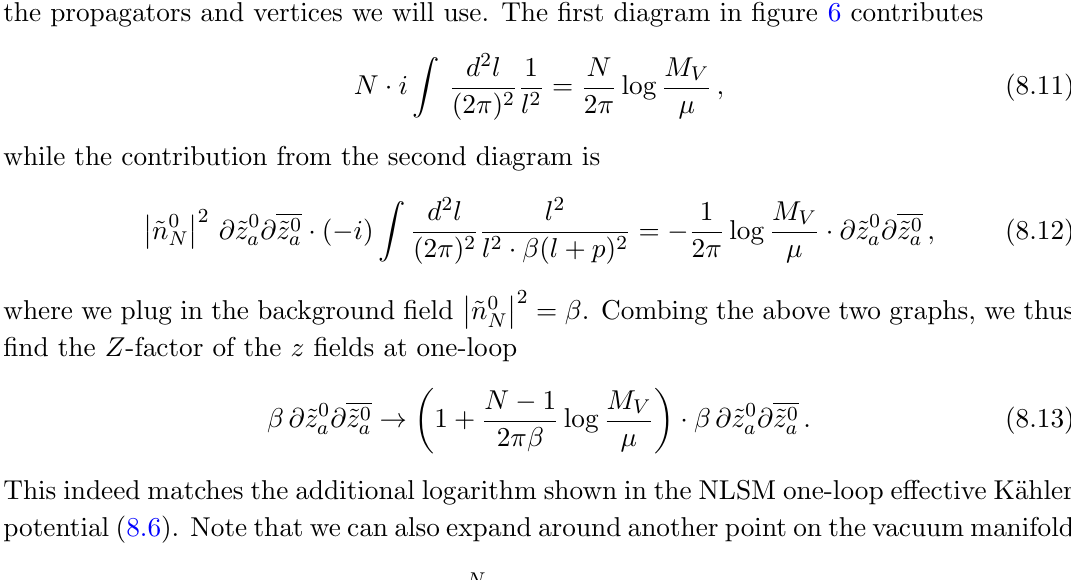
and @ ~ z 0 while the dashed lines present ~ n q a a . In the second diagram, the dashed line propagator is a